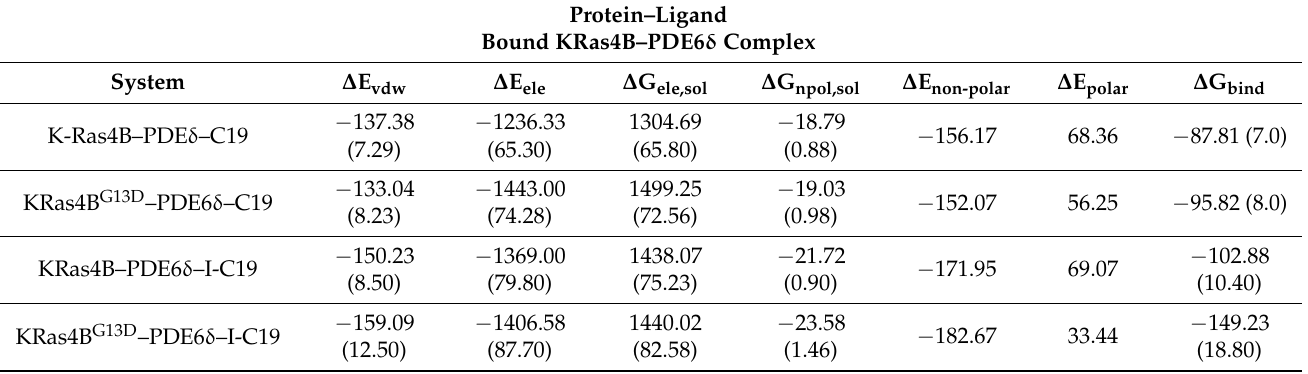
Table 1. Binding free energy components of the protein–ligand complexes (kcal/mol).